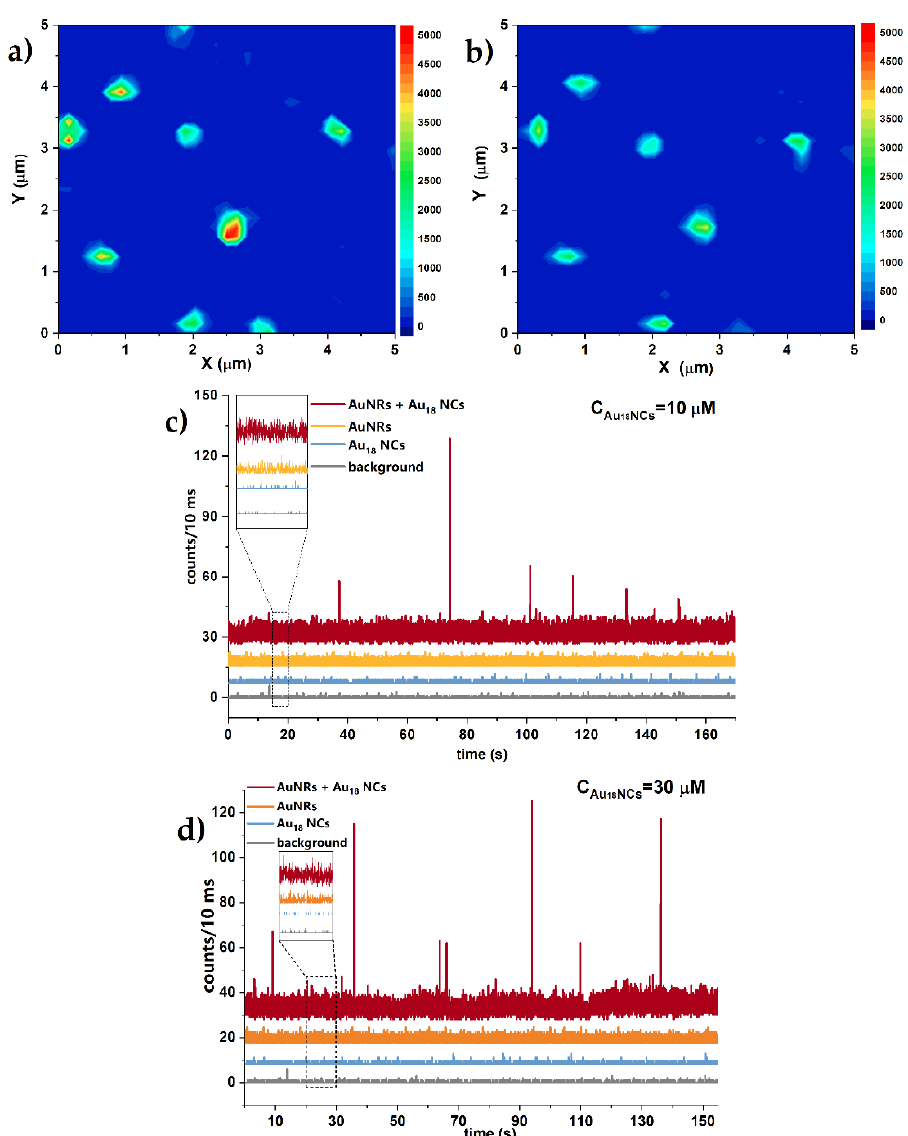
Figure 3. ( a , b ) TPL intensity map of well-separated AuNRs before ( a ) and after ( b ) covering with glycerine solution of AuNCs. ( c , d ) luminescence time traces of samples: AuNRs with local emission enhancement of floating AuNCs (red), solutions of AuNRs only (orange), AuNCs only (blue), and background noise (grey), monitored under prolonged irradiation of 70 µW in 10 ms photon counting window. AuNCs emission enhancement was determined in two concentration dependent conditions: ( c ) 10 µM and ( d ) 30 µM.